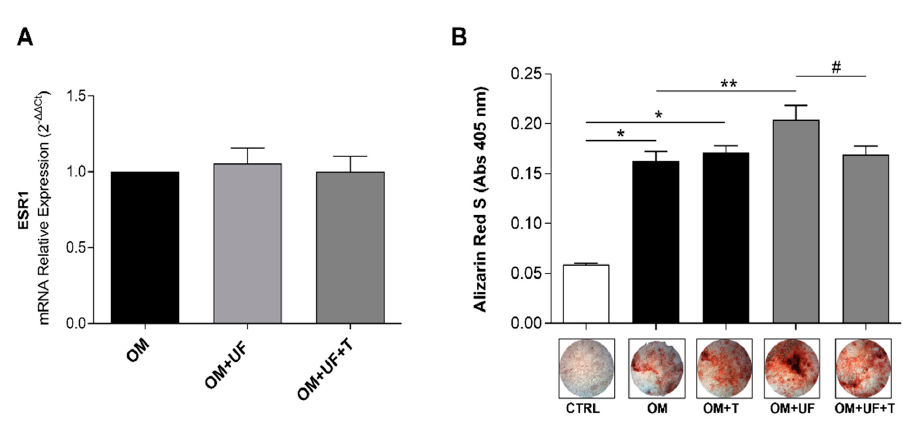
Figure 3. mRNA expression of ESR1, and effects of UF treatment on 2D-cultured hOBs: ( A ) Effect of UF on ESR1 expression following 14 days of treatment. Data are shown as the mean ± standard (error SEM). ( B ) hOBs were cultured for 14 days with CTRL medium and OM in the presence or absence of UF (10 µ M) and tamoxifen (5 µ M). Quantitative analyses of ARS were performed, and representative images were reported. Results are expressed as the mean ± standard error (SEM) ( n ≥ 3); * p < 0.05 vs. CTRL; ** p < 0.05 vs. OM; # p < 0.05 vs. OM + UF + T.